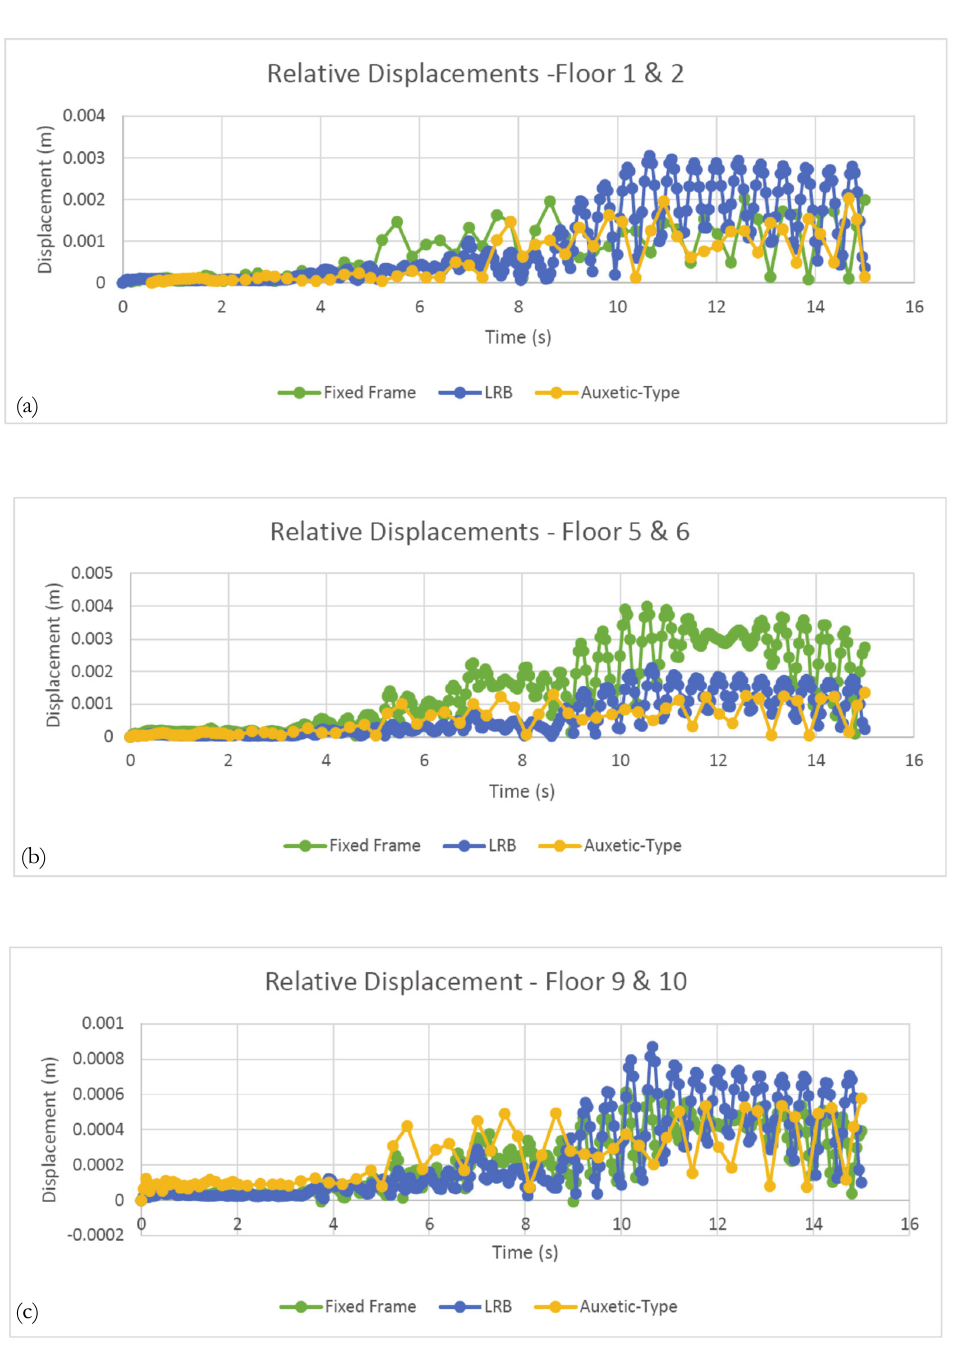
Figure 11: Relative displacement of floors (a) 1 and 2, (b) 5 and 6, (c) 9 and